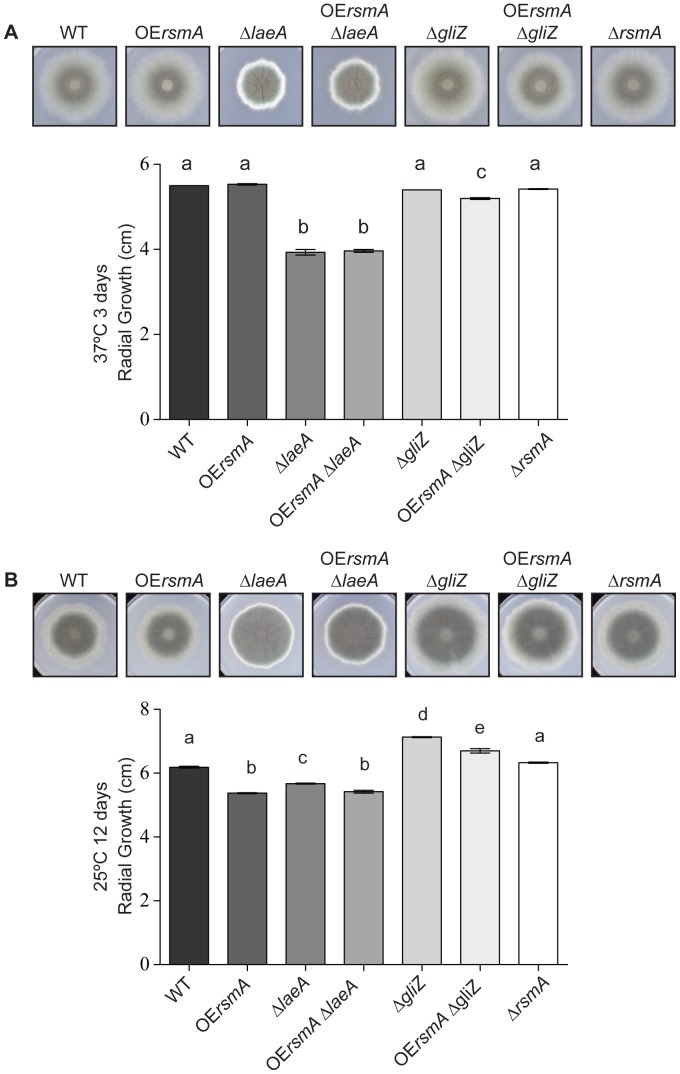
Average radial growth of A. fumigatus strains.104 conidia of each strain were point inoculated on GMM and grown at 37°C for 4 days and at 25°C for 12 days (Figure 1). Radial growth was measured at the end of each growth period. Means ± standard deviations are indicated for four replicates of each strain. Levels not connected by same letter are significantly different (P<0.0001) according to ANOVA analysis.